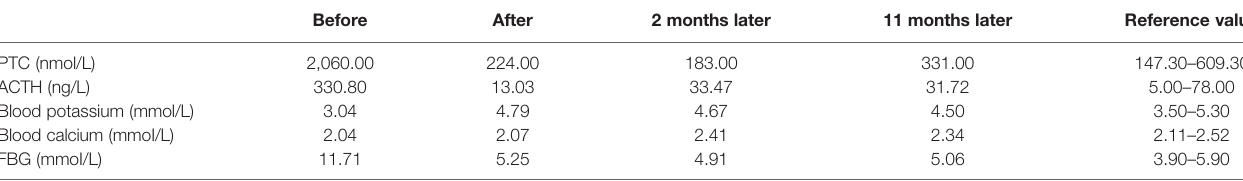
TABLE 2 | Biochemical and hormone values before and after the surgery.